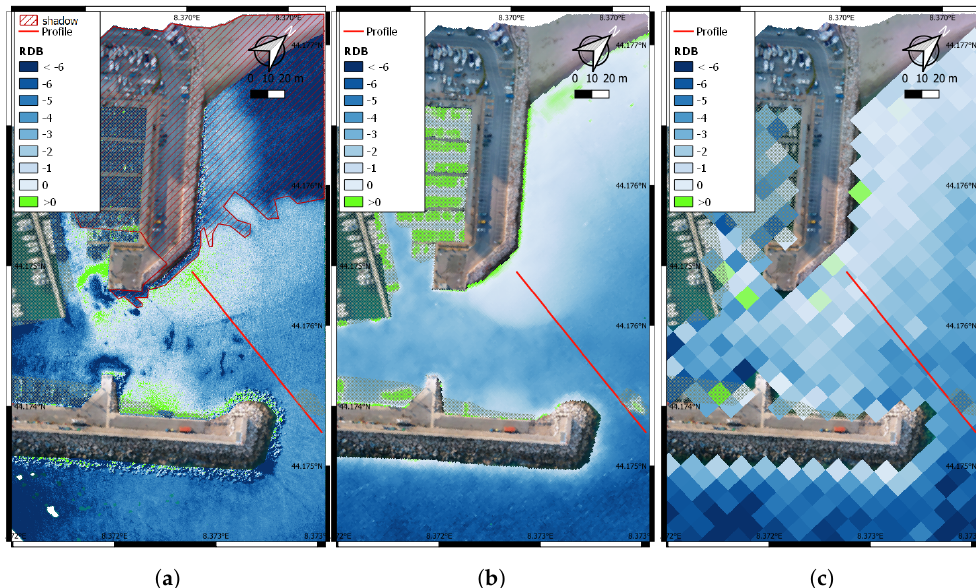
Figure 10. RDBs maps: ( a ) UAV-derived bathymetry, ( b ) aircraft-derived bathymetry and ( c ) S-2- derived bathymetry, showing depth values derived at three different resampled resolutions, 0.1 m, 1 m and 10 m, respectively. The red line indicates a transect used for bathymetry comparison in the following. The UAV-derived orthophoto is used as background. Capo San